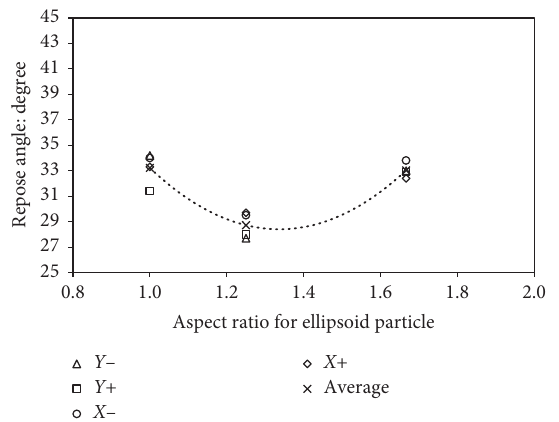
Figure 16: Angle of repose varies with the aspect ratio of the